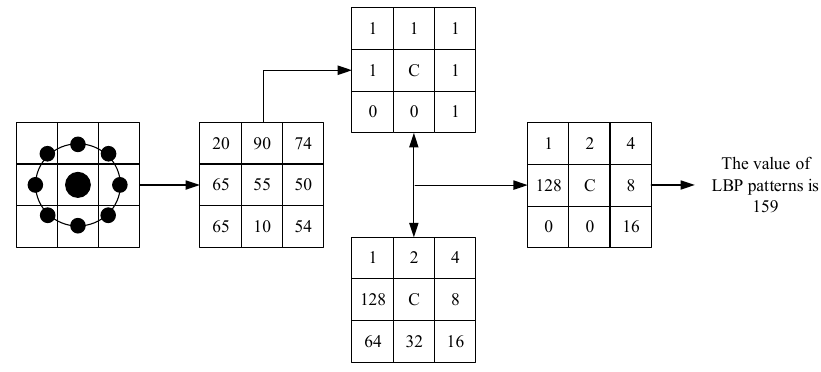
Figure 1. Metals 2018 , 8 , x FOR PEER REVIEW